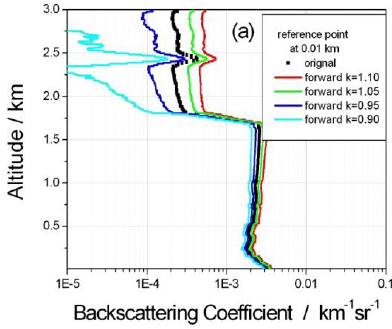
Fig. 1 Retrieval of the aerosol backscattering coefficient profile using the forward integral As to the forward integral, when we select the reference point at 0.01 km altitude, the original values of the aerosol backscattering coefficient at the reference point are 0.0033 km -1 sr -1 in Fig.1.